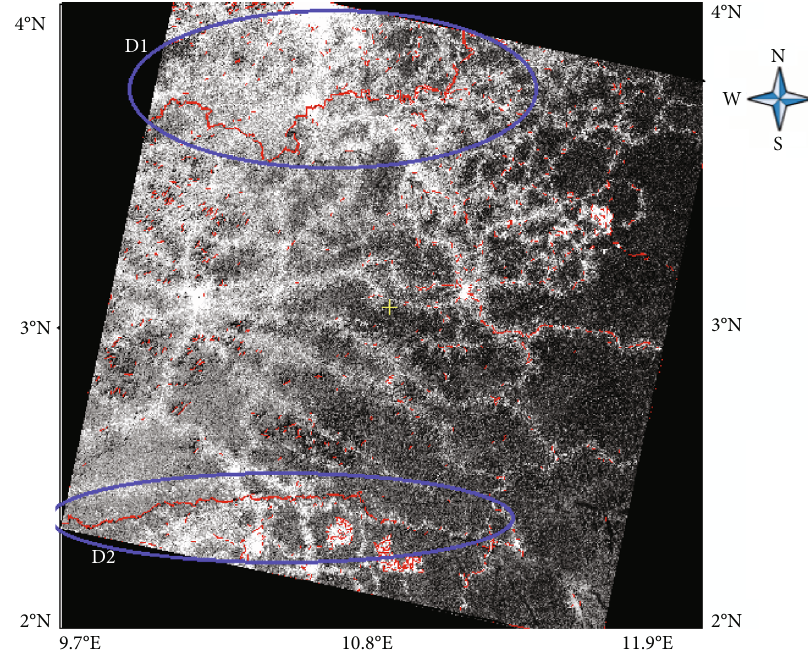
Figure 17: Regional lineament map of the study